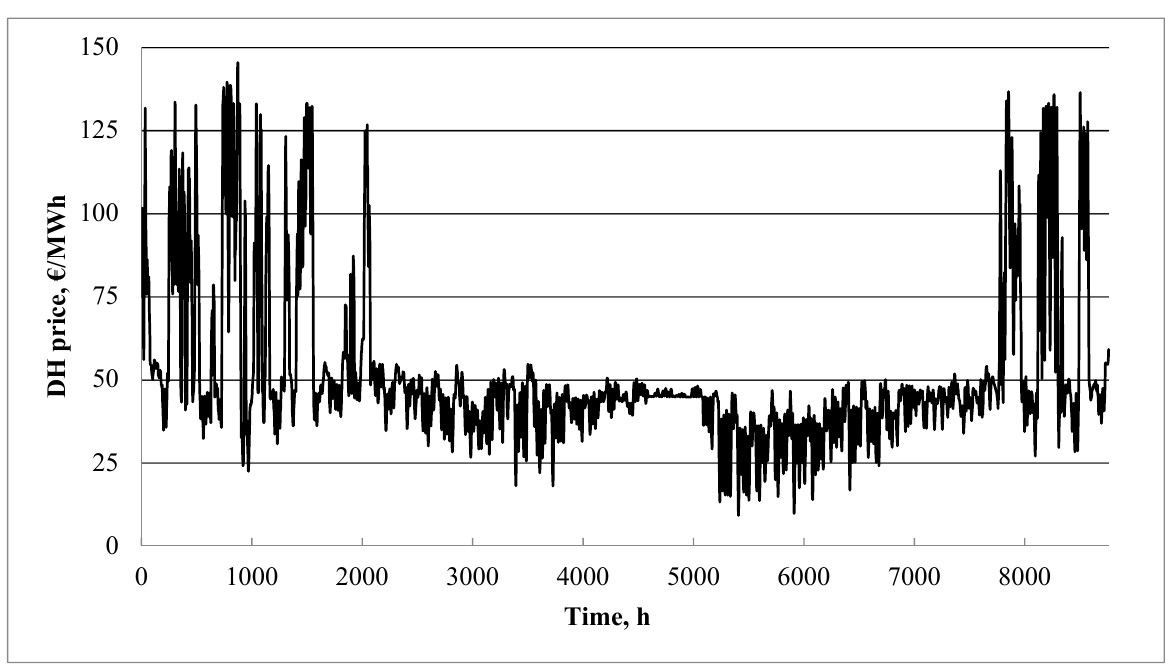
Figure 2. Hourly DH prices.